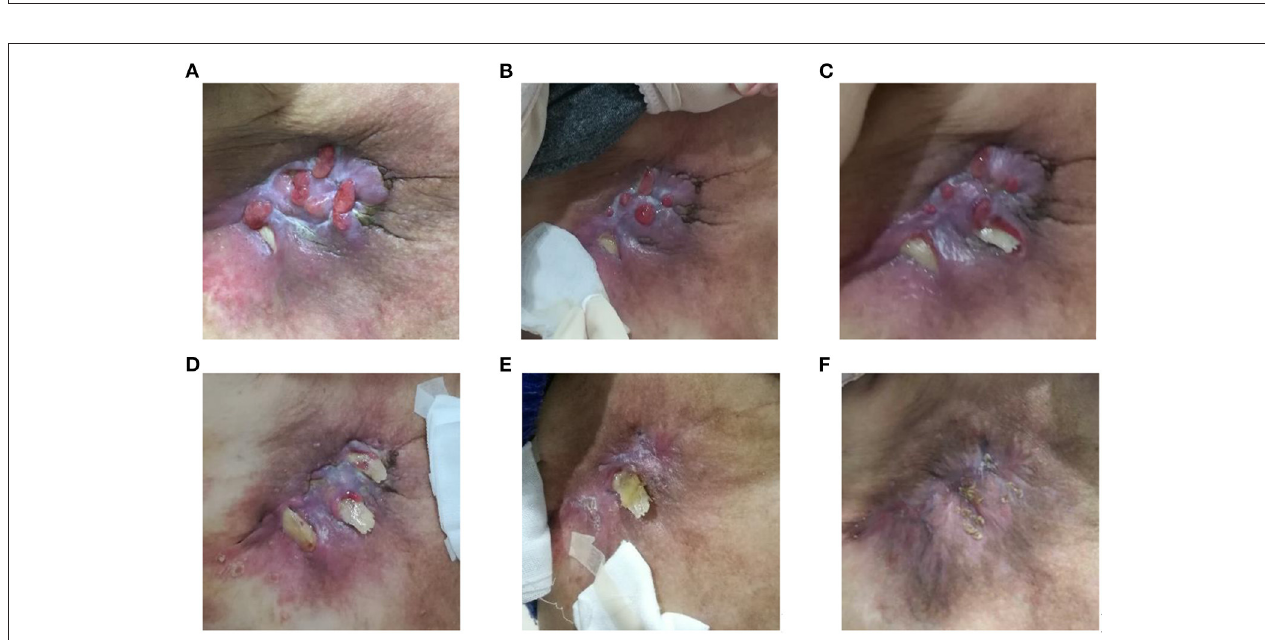
FIGURE 2 | Sore and ulcers. (A) Severe sore at the first visit (with eight ulcers on right chest). (B–E) By the second and fifth visits, the sore and ulcers were significantly improved. (F) At the sixth visit, the ulcers had already